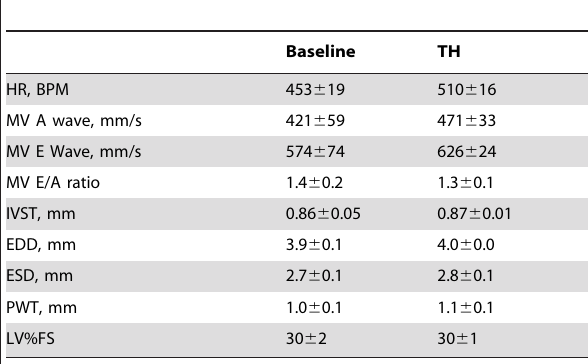
Table 2. Functional measurement during isolated working heart with 13 C-labeled substrates at high afterload (80